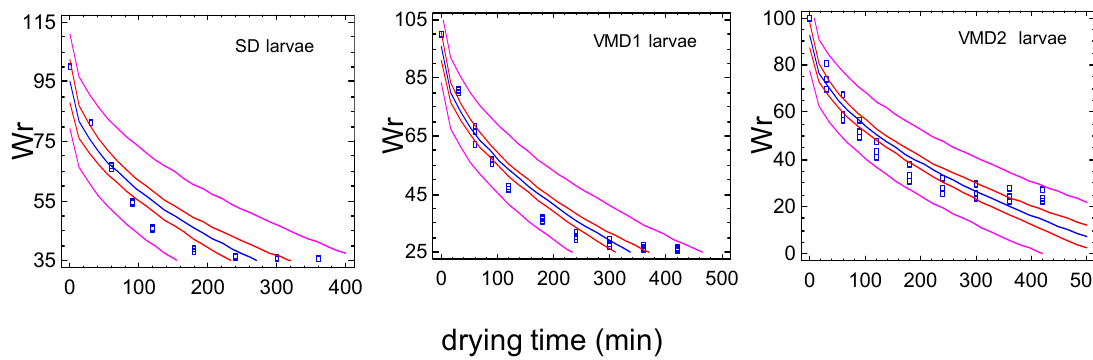
Figure 5. Square root-X models of percent residue weight (Wr) vs. drying time: Fitted model (blue line), confidence limits at 95% level (red lines), prediction limits (purple lines) and experimental data.